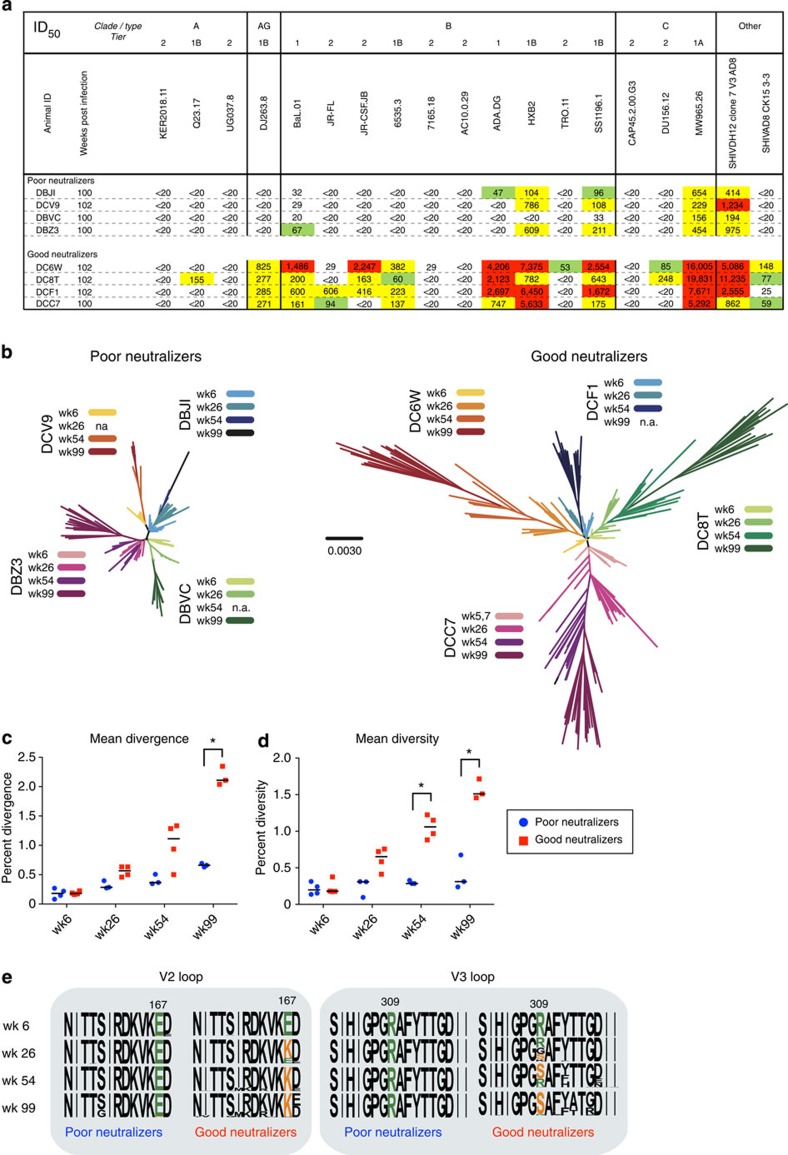
Serum neutralization breadth and viral diversity during SHIVAD8 infection.(a) Plasma neutralization of selected viruses 100–102 weeks post infection with SHIVAD8. Eight animals were segregated into good and poor neutralizers on the basis of the potency and breadth of their responses. ID50 values are shown; colours indicate potency: 40–99, green; 100–999, yellow; ≥1,000, red. (b–d) Viral sequencing was performed on plasma from SHIV-infected NHP at week 6, 26, 54 and 99, except where indicated. (b) Phylogenic trees of Env sequences rooted to the inoculum sequence for good and poor neutralizers. Colours indicate time points; scale bar indicates 0.3% divergence. The mean divergence (c) or diversity (d) was calculated for each animal at the indicated time points. Horizontal bars indicate group medians; *, significant discovery by multiple t-test comparison. Sequence data were not available for DBVC wk 54, DCV9 wk 26 and DCF1 wk99 because of low viral titres. (e) Consensus Env sequences at the indicated time points highlighting the V2 and V3 loops. Conserved mutations at amino-acid positions 167 and 309 are shown (orange) compared with the original residue (green) in the good and poor neutralizer animals.